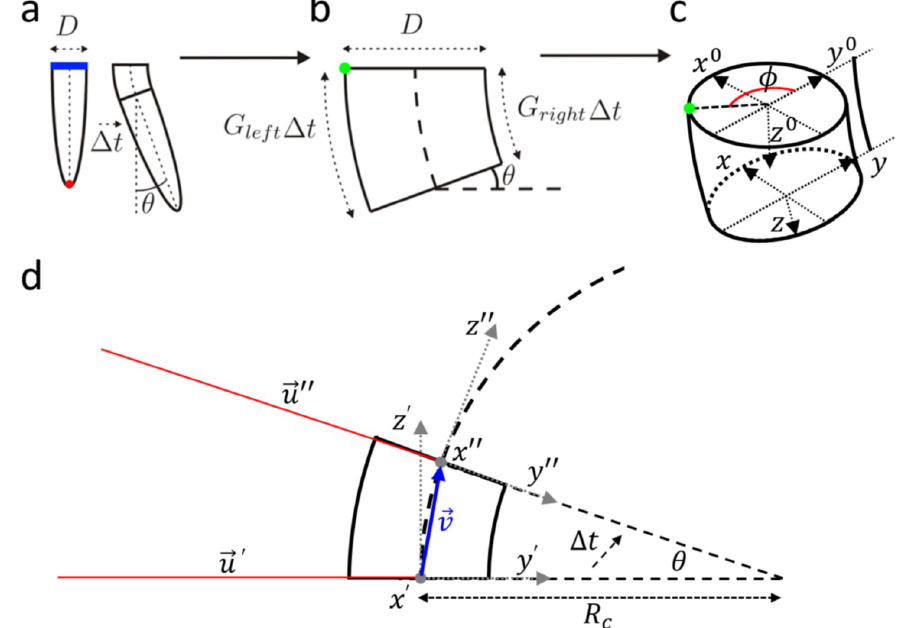
Fig 1. Schematic of root parameters and growth kinematics. The mechanism of differential growth for a single time step ( Δ t ) is summarized for our modification of the 2-dimensional model of Tsutsumi [31]. (a) The root before and after a bend of θ . The red dot identifies the tip of the root, and the blue line highlight the diameter D . (b) A close view of the region with the bending. The differential growth is achieved by a different growth rate ( G example) obtained at opposite sides of the root. (c) A 3-D view of the cross-section of the root, the local coordinate system is shown before Ox 0 y 0 z 0 and after Oxyz the differential growth. This 3-D section is representative for the shape of segments defined on the root at each iteration. Outside of the root is drawn the reference curve location (black line in the direction of the y axis), the point having highest growth rate (green dot) and the corresponding ϕ angle, which corresponds to the angle between the y axis and the point of highest growth rate. (d) The kinematics for the same growth step.